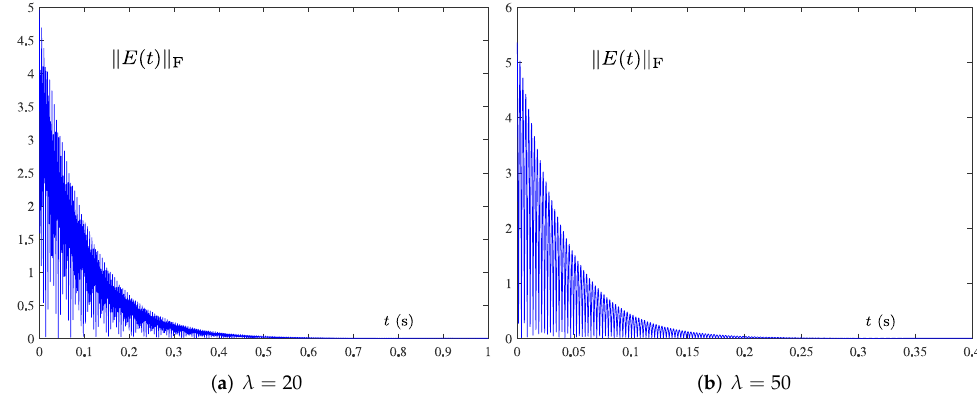
Figure 9. Simulation results under the aperiodic multiple-harmonic noise, OAZNN model (38) for TVMIP of (40) with λ = 20,50 respectively.